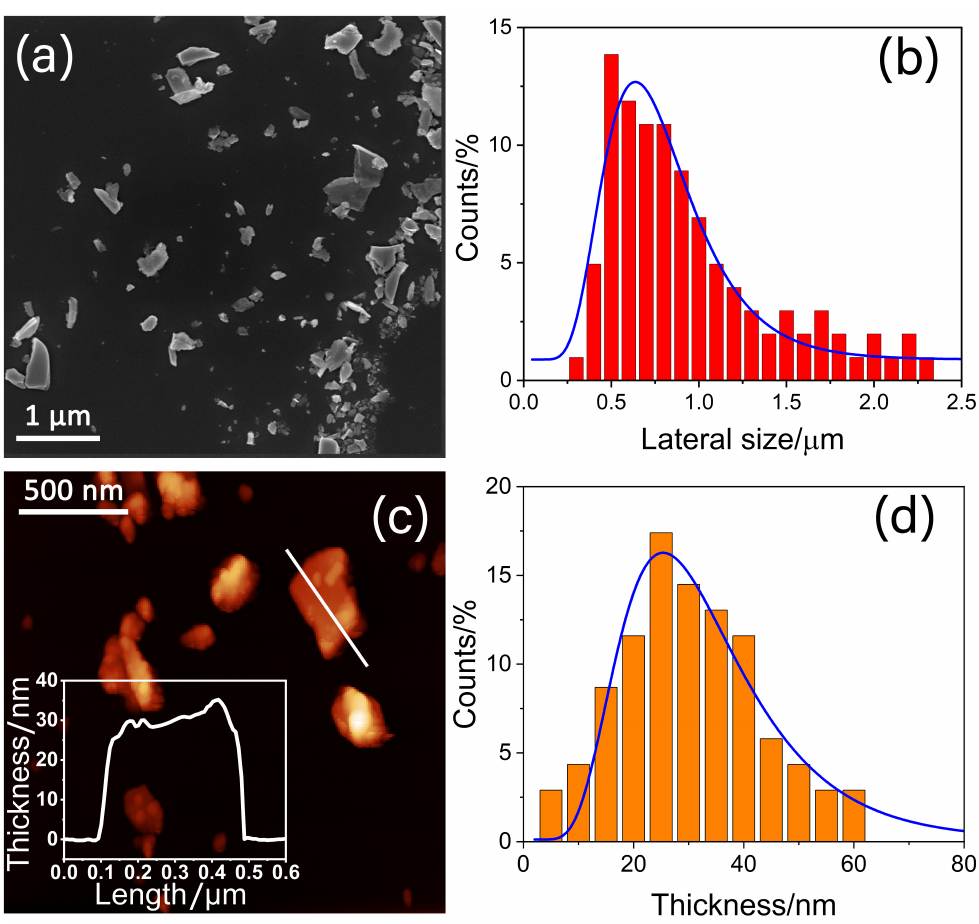
Figure 2. ( a ) High-resolution SEM image of representative SnSe 2 nanoflakes. ( b ) Statistical analysis of lateral dimension calculated from SEM images. The blue curve represents the Gaussian fit. ( c ) Representative AFM image of SnSe 2 nanoflakes. The inset shows the height profile of the flake indicated by the segment in white. ( d ) Statistical analysis of the SnSe 2 flake thickness distribution calculated from AFM images. The blue curve is the log-normal distribution fit.